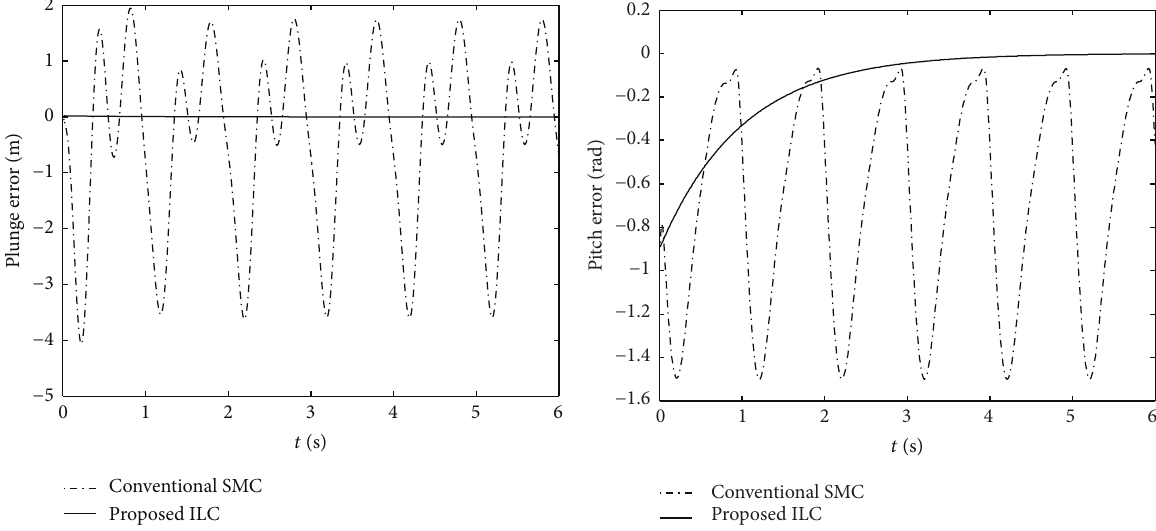
disturbance remain unchanged, system response